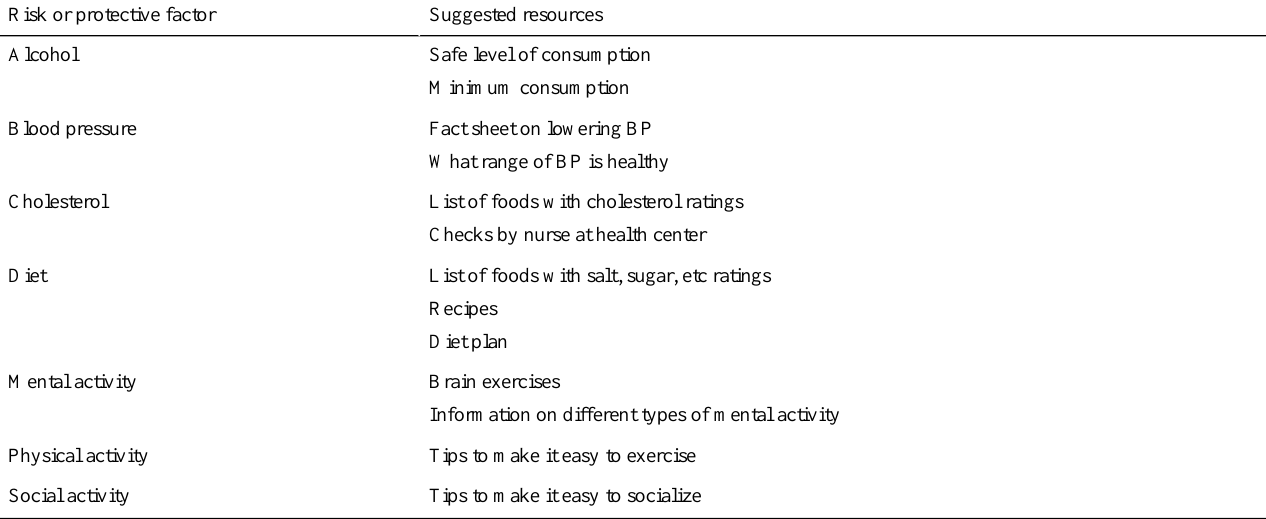
Table 8. Selected responses to the open question “What else do you think you need to help you to make changes to improve what you do in relation to the factors listed? Are there any particular resources, facilities, information, services, etc, that you think would help